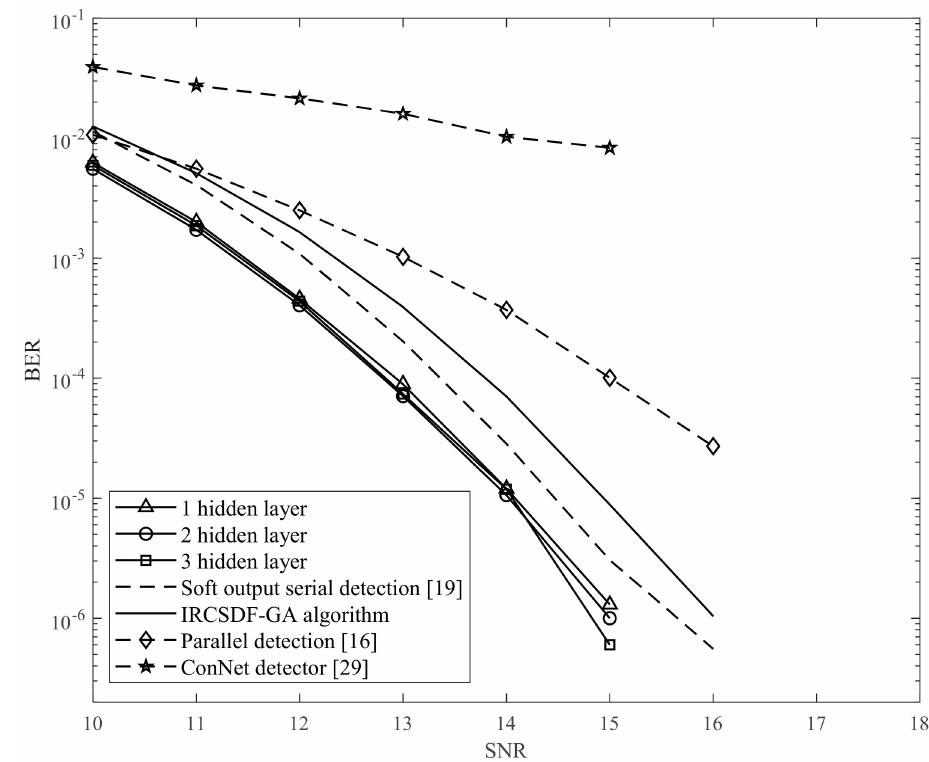
Figure 17. The BER performance of the third